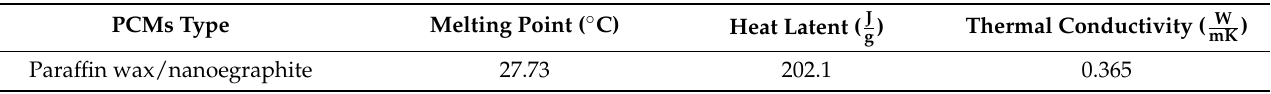
Figure 1. Schematic of the proposed photovoltaic–thermal hybrid system. Table 1. PCM properties [48].